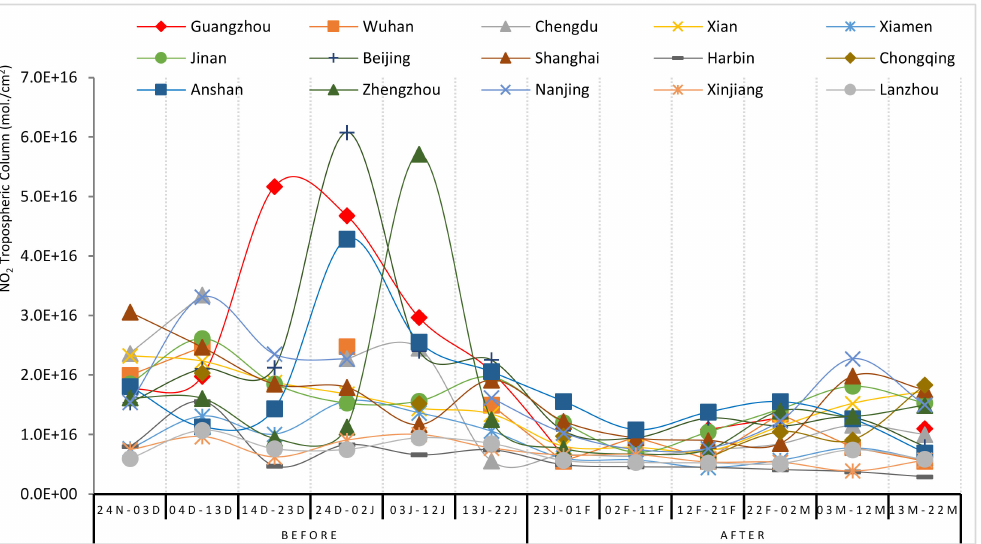
Figure 2. Temporal variation (10 days average) in NO 2 tropospheric column of 15 major cities of China before and after the pandemic. Sources: Calculated by author,